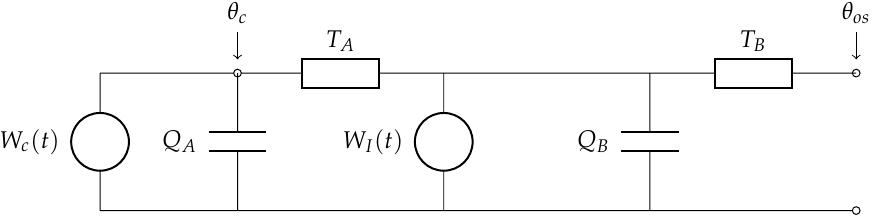
Figure 14. Reduced thermal ladder network representing a three-core XLPE submarine